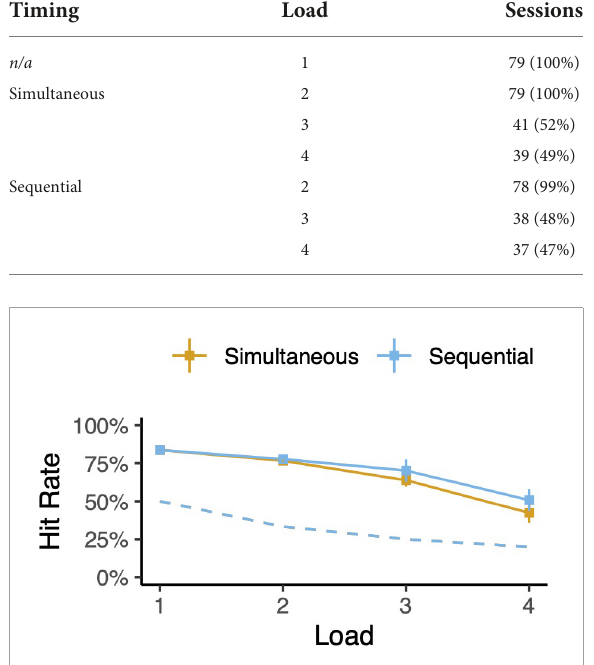
FIGURE3 Task performance. Hit rates for each trial type (simultaneous or sequential) as a function of memory load. Error bars depict 95% confidence intervals. Dotted lines indicate chance